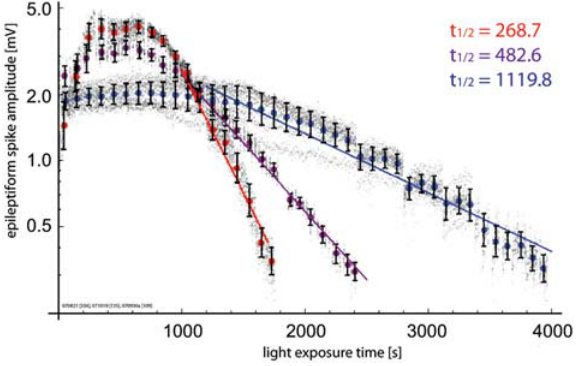
Figure 4. ‘‘Bleaching’’ kinetics are related to illumination intensity. ‘‘Bleaching’’ kinetics are compared from observations at three light intensities within our setup described in Figure 1: 12 V (85 W, red), 10 V (63 W, purple), and 8 V (44 W, blue). Stronger illumination is correlated with faster ‘‘bleaching’’ kinetics, both during the initial non- exponential phase and during the latter exponential phase. doi:10.1371/journal.pone.0004041.g004 independent of superficial or meningeal staining. The final convergence also suggests against enzymatic and/or phototoxic complications leading to the non-exponential phase.